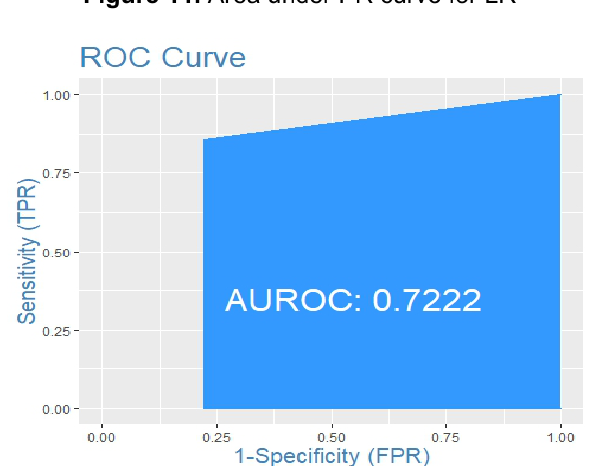
Figure 12. Area under ROC curve for